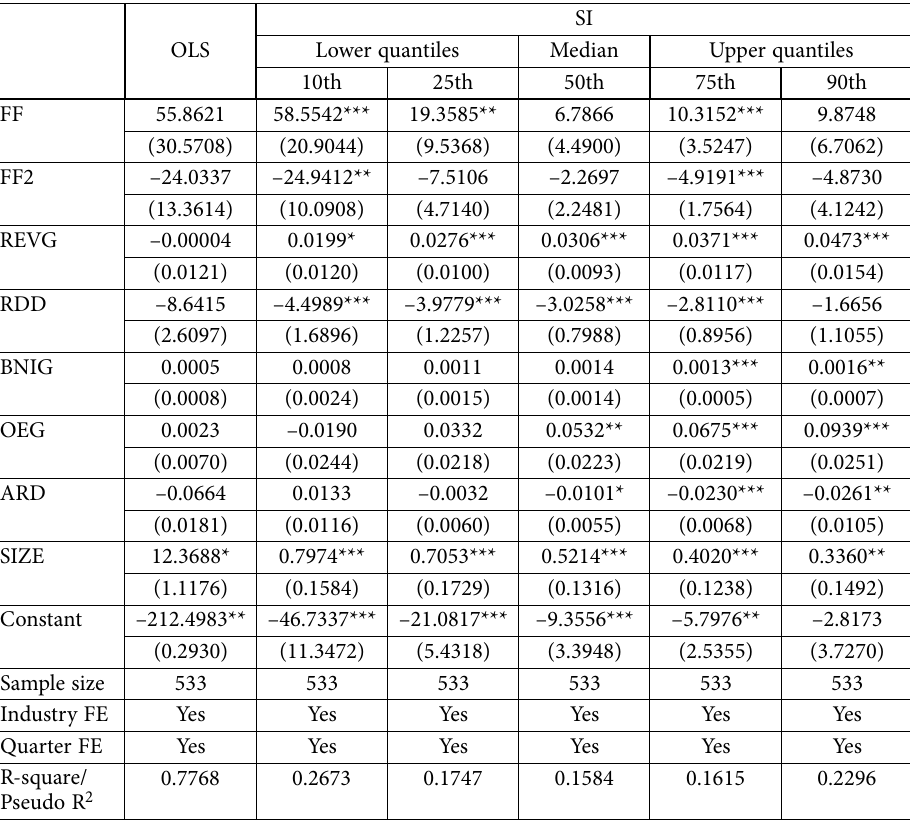
Table 16. Summary of OLS and QR analysis for the SI in 2019